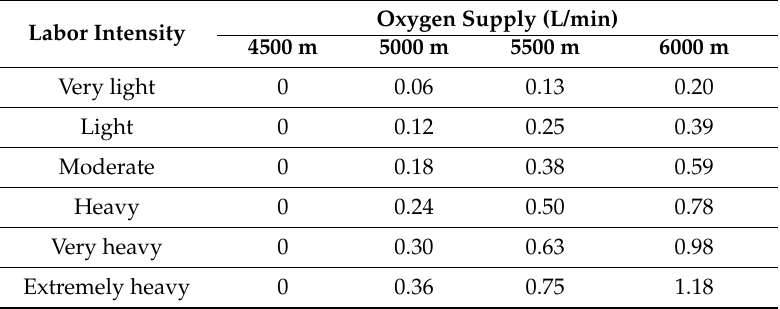
Table 11. Oxygen-supply standard based on safety of construction personnel. Labor